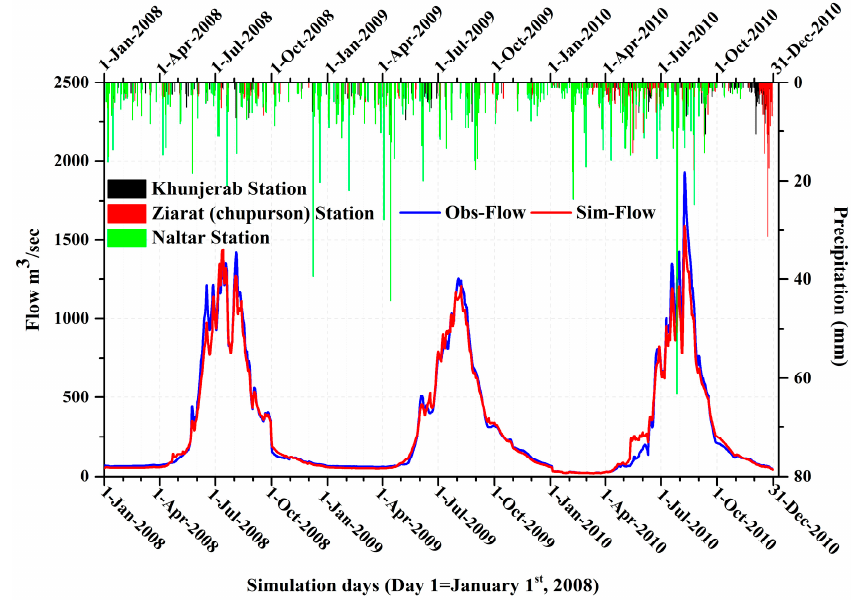
Figure 4. Observed and simulated daily outflow for the validation period (2008–2010).